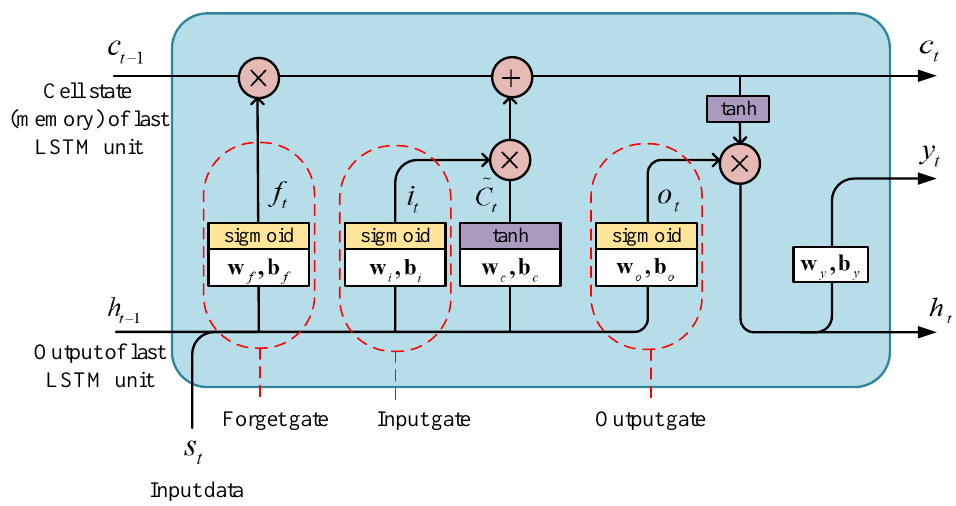
Figure 6. The structure of an LSTM